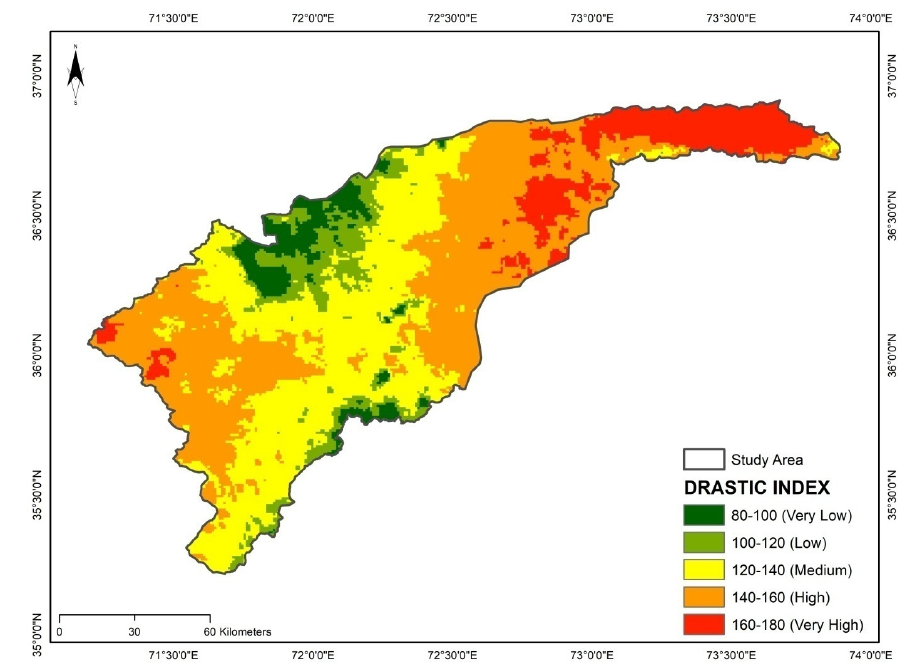
Figure 4. DRASTIC index map of Chitral district.